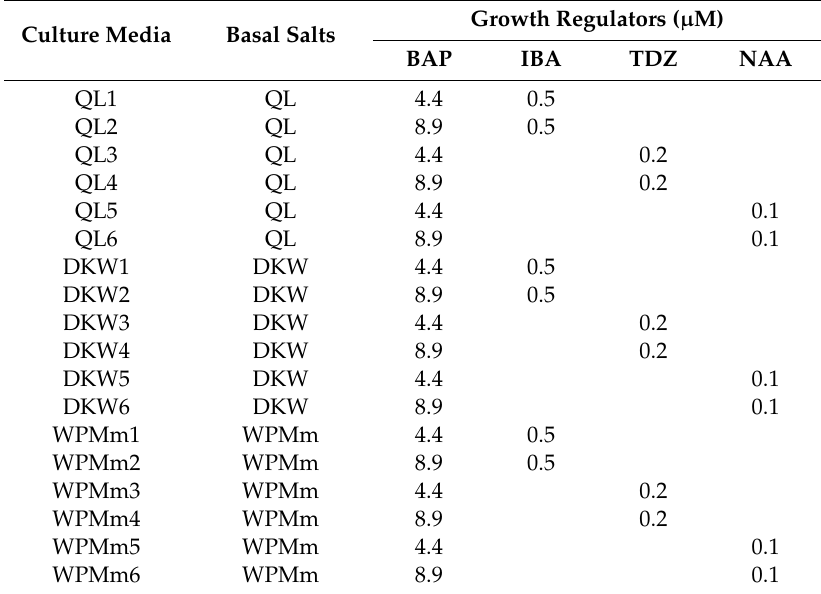
Table 4. Combination of basal salts and growth regulators used in the regeneration media. Culture Media Basal